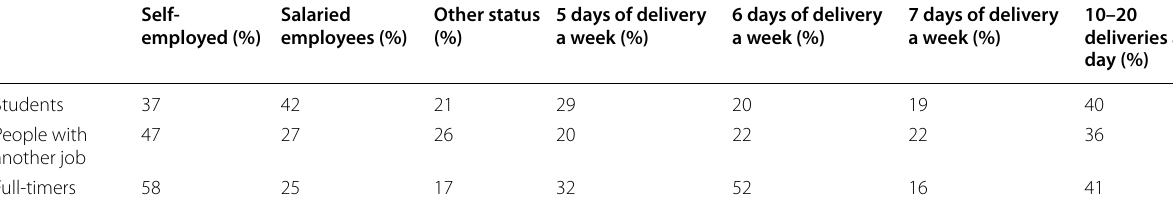
Table 2 Working conditions of the couriers in 2021. Source : Author’s survey Self- Salaried employed (%) employees (%)